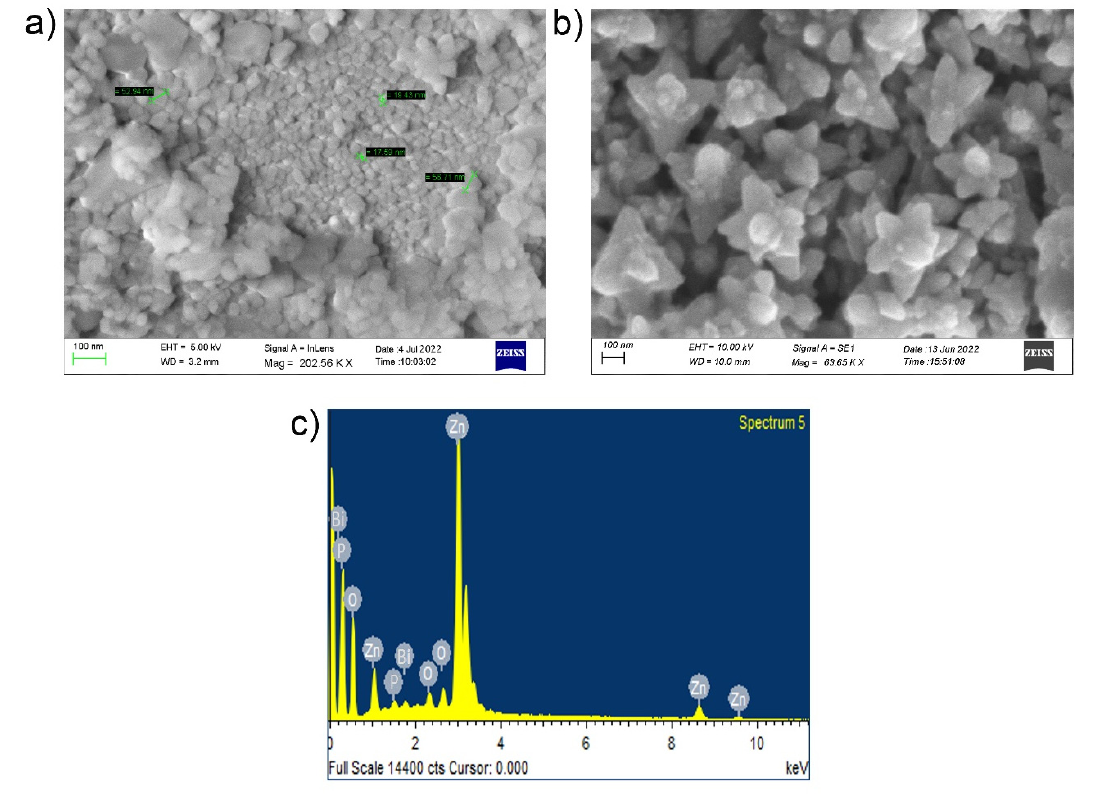
Figure 3. ( a ) SEM observation; ( b ) Fe-SEM observation; ( c ) EDS spectrum image of flower-like BiPO 4 /ZnO-NCs (B1Z4-75:300; NCs-4).